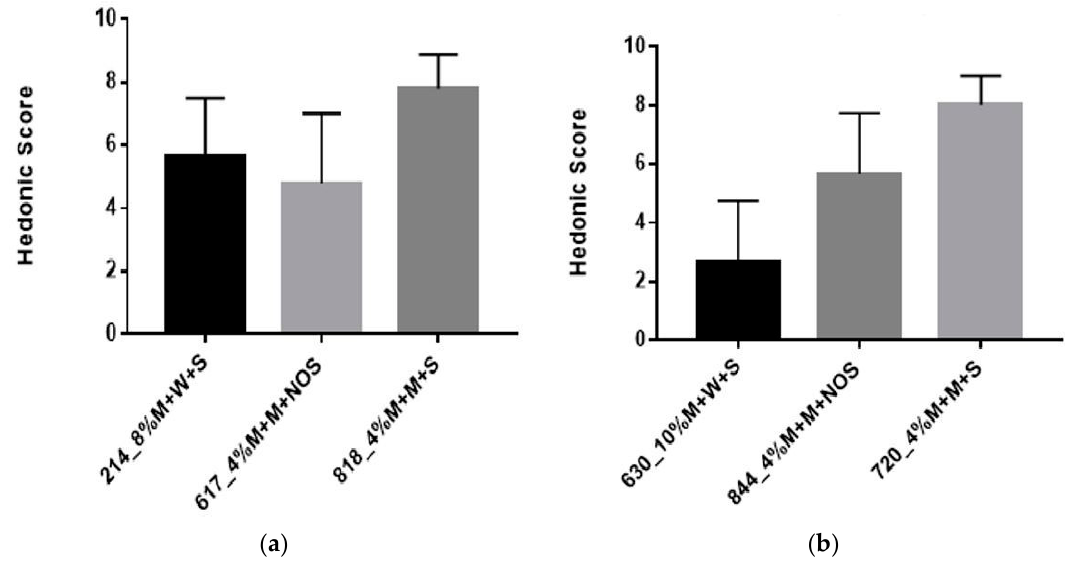
Figure 7. ( a ) Results from the hedonic test Panel Test A; ( b ) Results from the hedonic test Panel Test B. Figure 7. ( a ): Results from the hedonic test Panel Test A; ( b ): Results from the hedonic test Panel Test M = millet, W = water, S = sugar, NOS = no B. M = millet, W = water, S = sugar, NOS = no sugar.